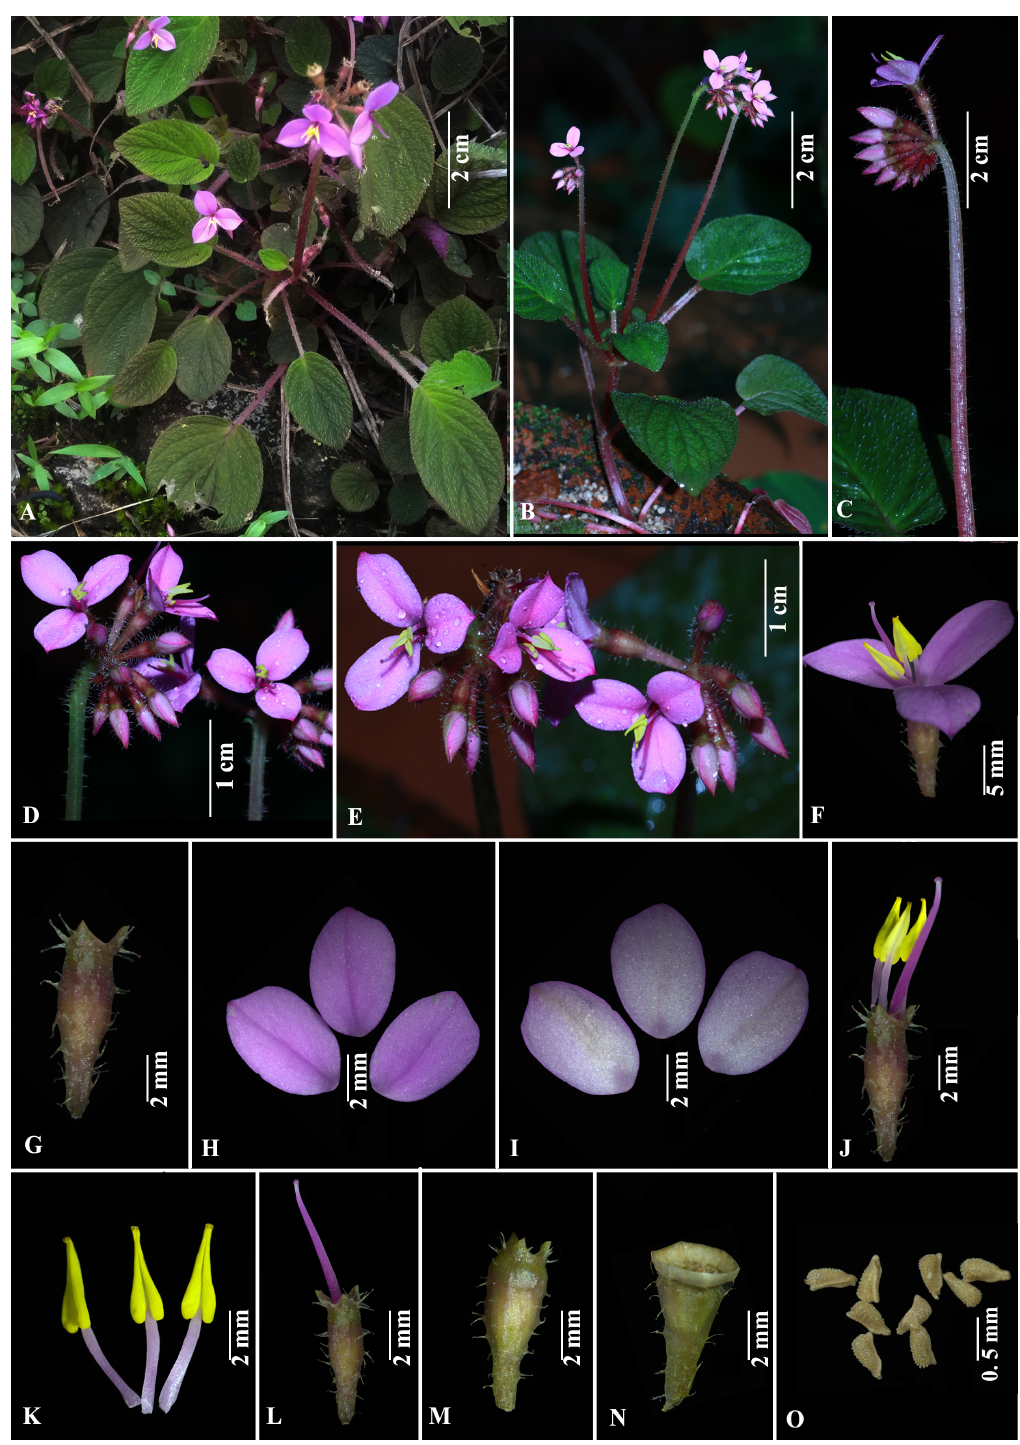
Fig. 3. Sonerila longipedunculata Resmi & Nampy sp. nov . A . Habit. B . Plant with three inflorescences emerging from the distal node. C . Inflorescence. D – E . A portion of the inflorescence showing buds, flowers with glandular trichomes on peduncle, hypanthium and the abaxial surface of petals. F . Single flower. G . Hypanthium. H . Petals, adaxial view. I . Petals, abaxial view. J . Hypanthium with stamens and pistil. K . Stamens. L . Pistil. M . Capsule. N . Dehisced capsule. O . Seeds. Photographs by Resmi S. based on Resmi S. & Santhosh Nampy 151222